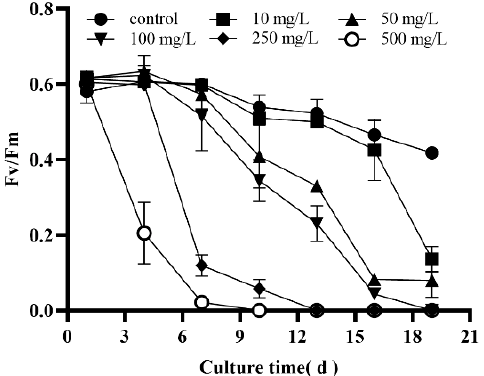
Figure 2. Effect of different concentrations of selenite on the chlorophyll fluorescence parameters Fv/Fm.